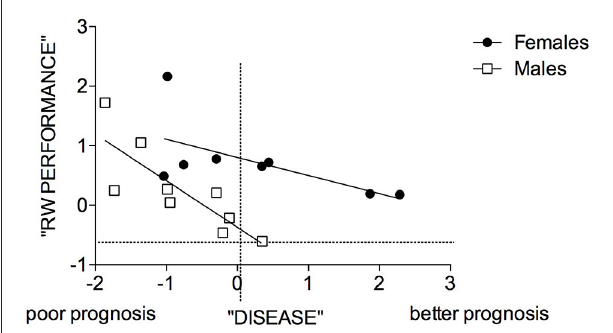
FIGURE 9 | Correlation between “disease” and “RW performance” components in male and female SOD1G93A mice of the 3 RW exercise group. Symbols represent male and female mutant individuals exposed to 3 RW exercise sessions. Regression lines intercepts are significantly different [ F (1,14) = 10.68, p =